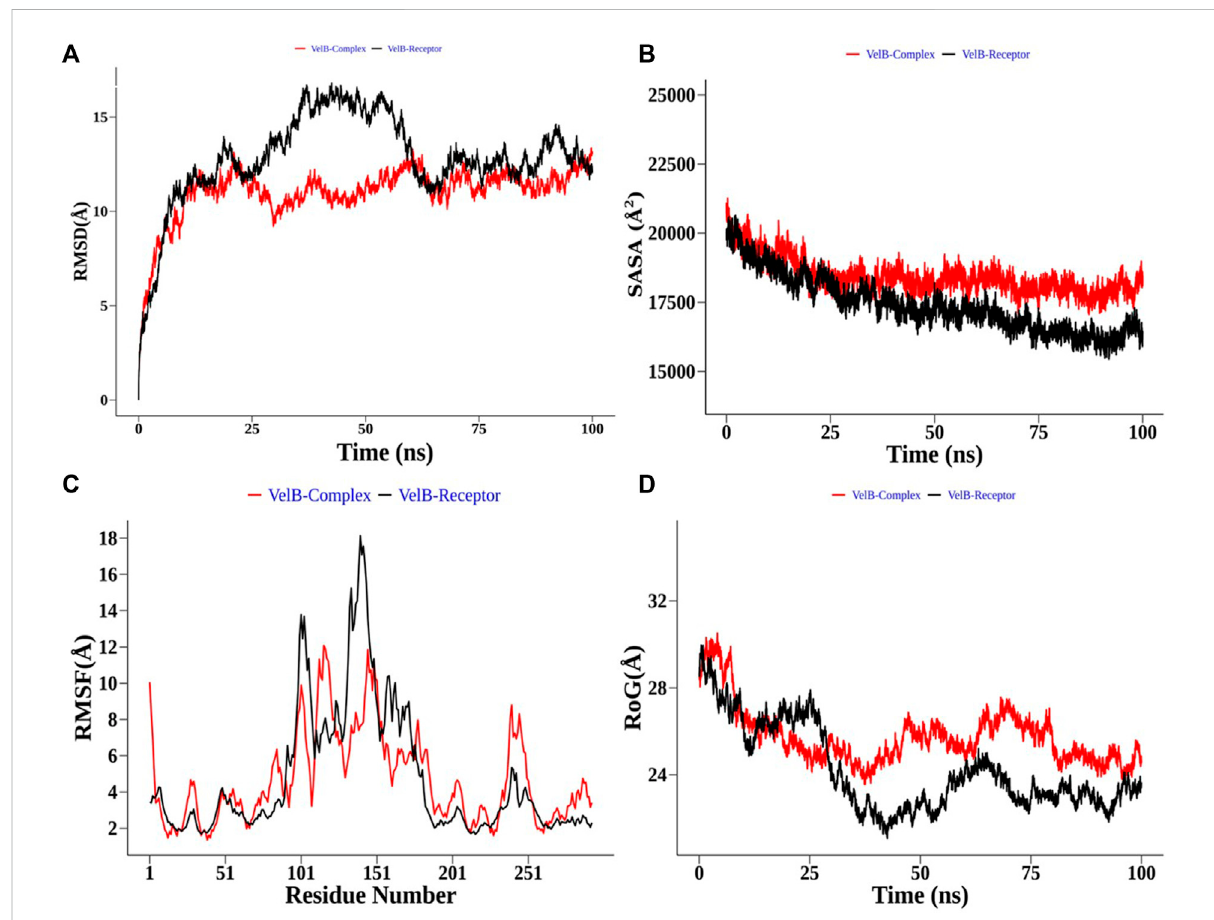
FIGURE 9 Structural order parameter analysis of the VelB complex (curcumin) with respect to the VelB receptor. (A) Root mean square deviation (RMSD), (B) solvent-accessible surface area (SASA), (C) root mean square fl uctuation (RMSF), and (D) radius of gyration (RoG)